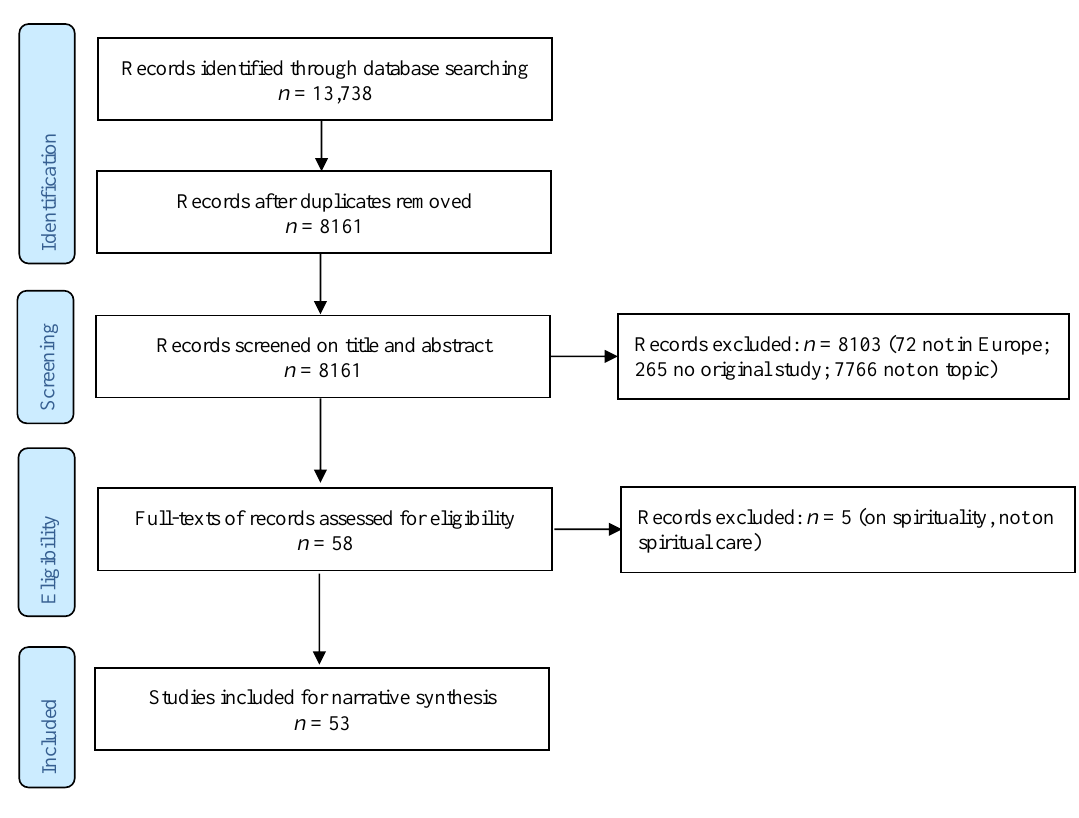
Figure 1. Flowchart. Figure 1.